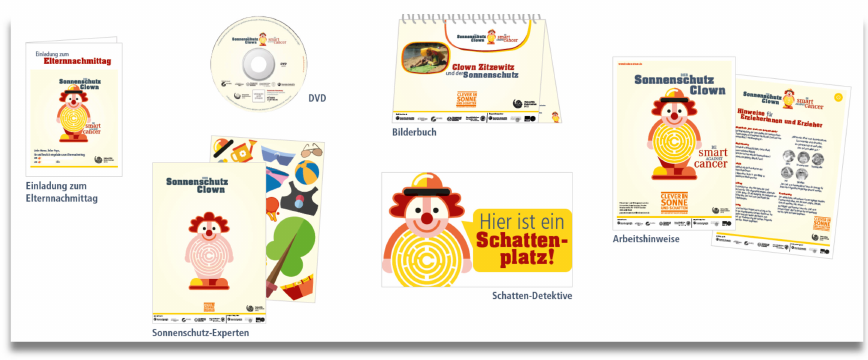
Figure 2. CLEVER material for project week © NCT/UCC